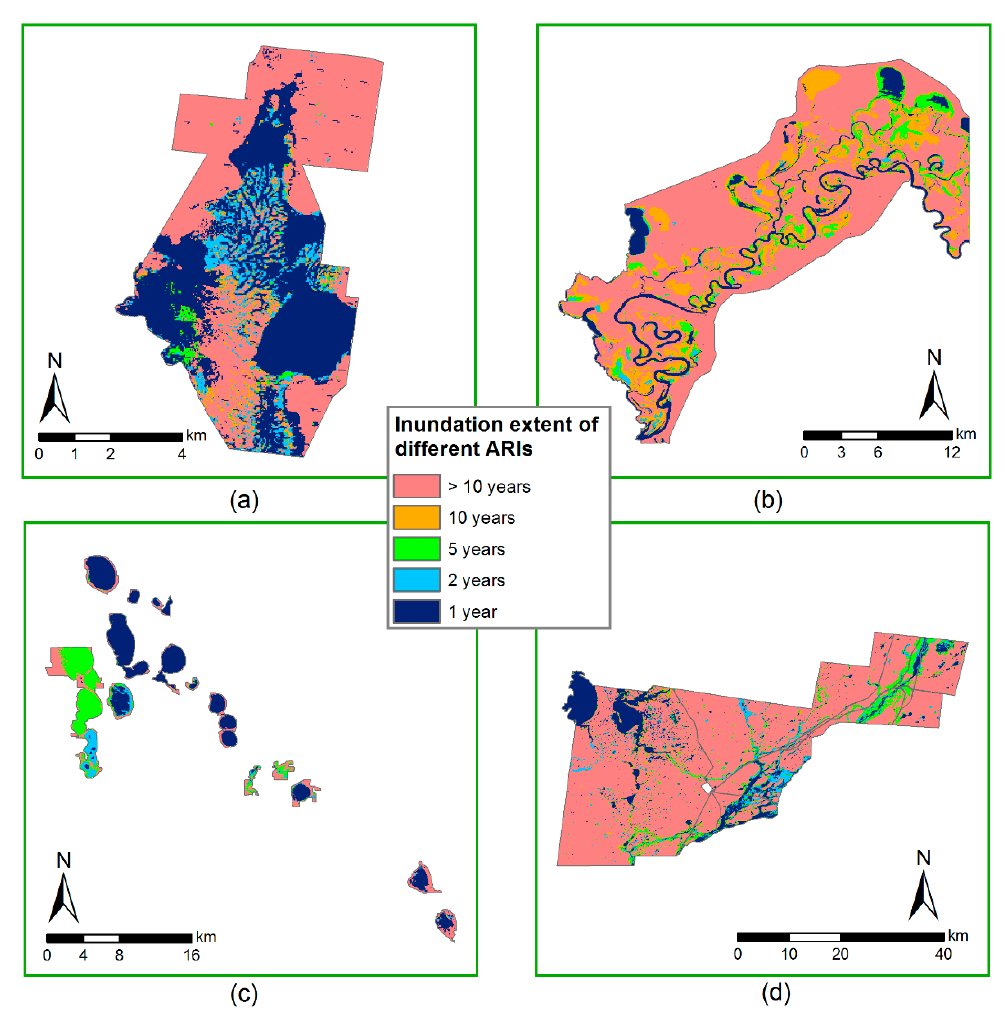
Figure 6. ARI maps for ( a ) Narran Lake Nature Reserve, ( b ) Riverland, ( c ) Kerang Wetlands ( d ) Currawinya Lakes.